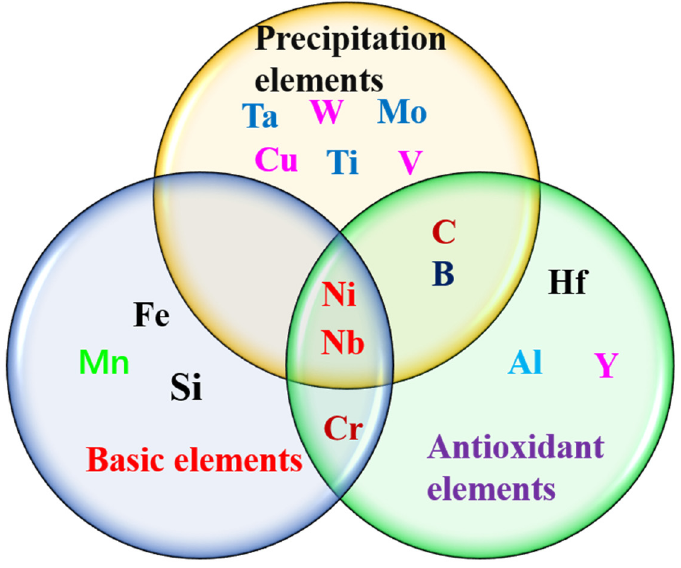
Figure 1. The alloy elements in AFA steel.